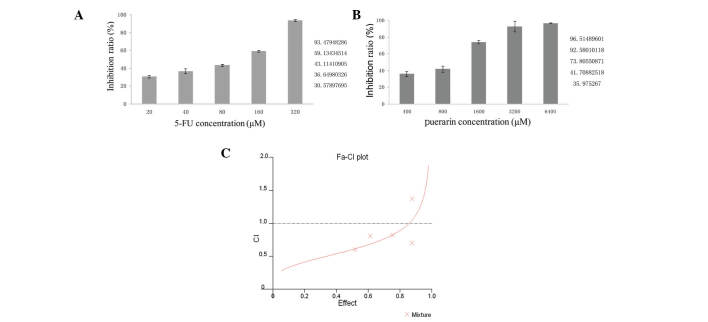
Effect of puerarin or 5-FU alone on BGC-823 cells. The proliferation of BGC-823 cells was inhibited by (A) 5-FU and (B) puerarin in a dose-dependent manner (P<0.01 compared with 20 μM 5-FU and 400 μM puerarin, respectively). (C) The CI values were determined by the method by Chou and Talalay. As shown here, the CI values are <1 when the fractions affected are <0.8775. Thus, puerarin and 5-FU at certain concentrations had synergistic effects in inhibiting the proliferation of BGC-823 cells. 5-FU, 5-fluorouracil; CI, combination index; fa, fraction of the system affected by the dose.